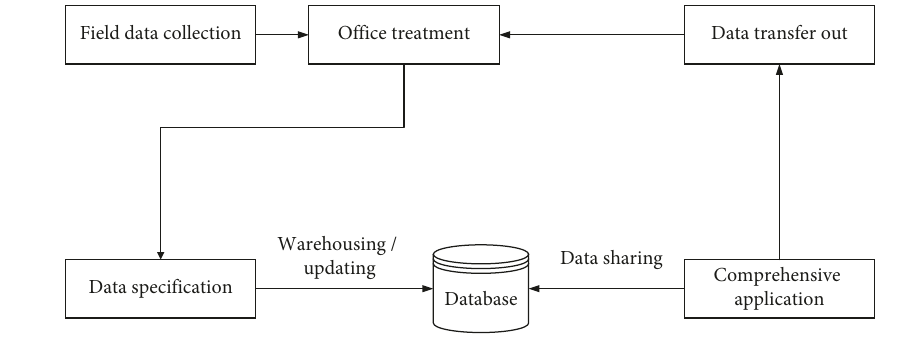
Figure 2: Data warehousing